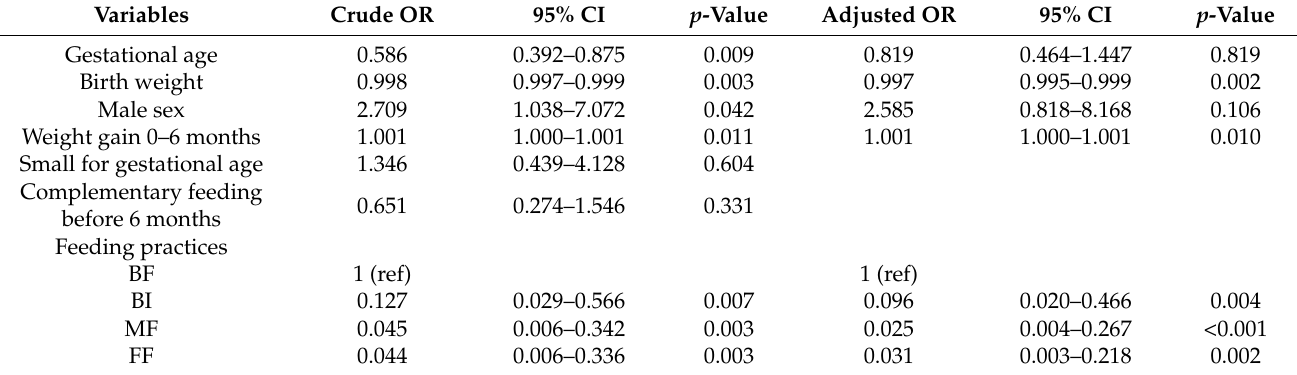
Table 3. Logistic regression analyses of factors associated with iron deficiency anemia in 6-month-old